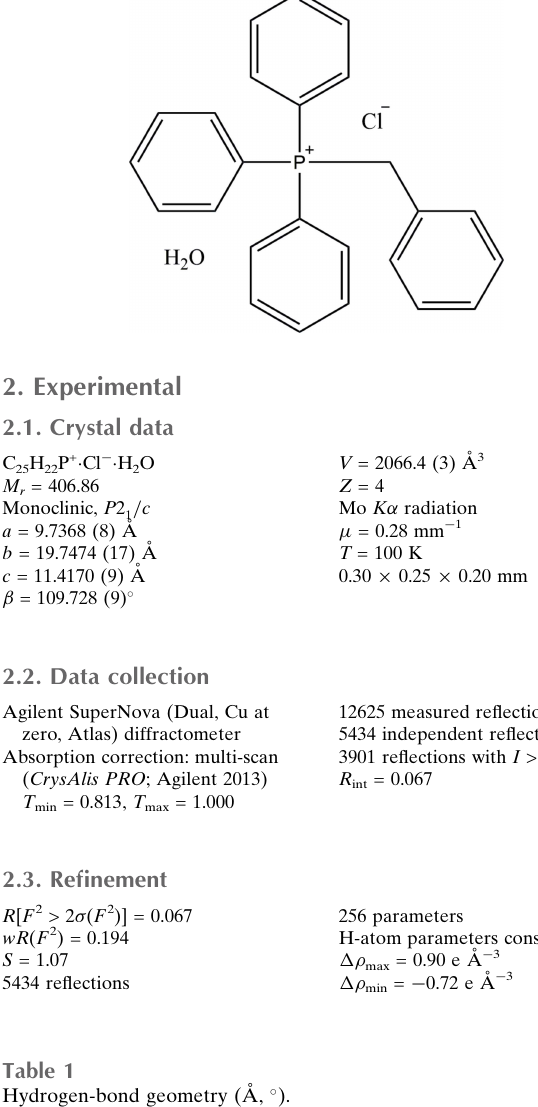
Hydrogen-bond geometry (A˚ , (cid:4)